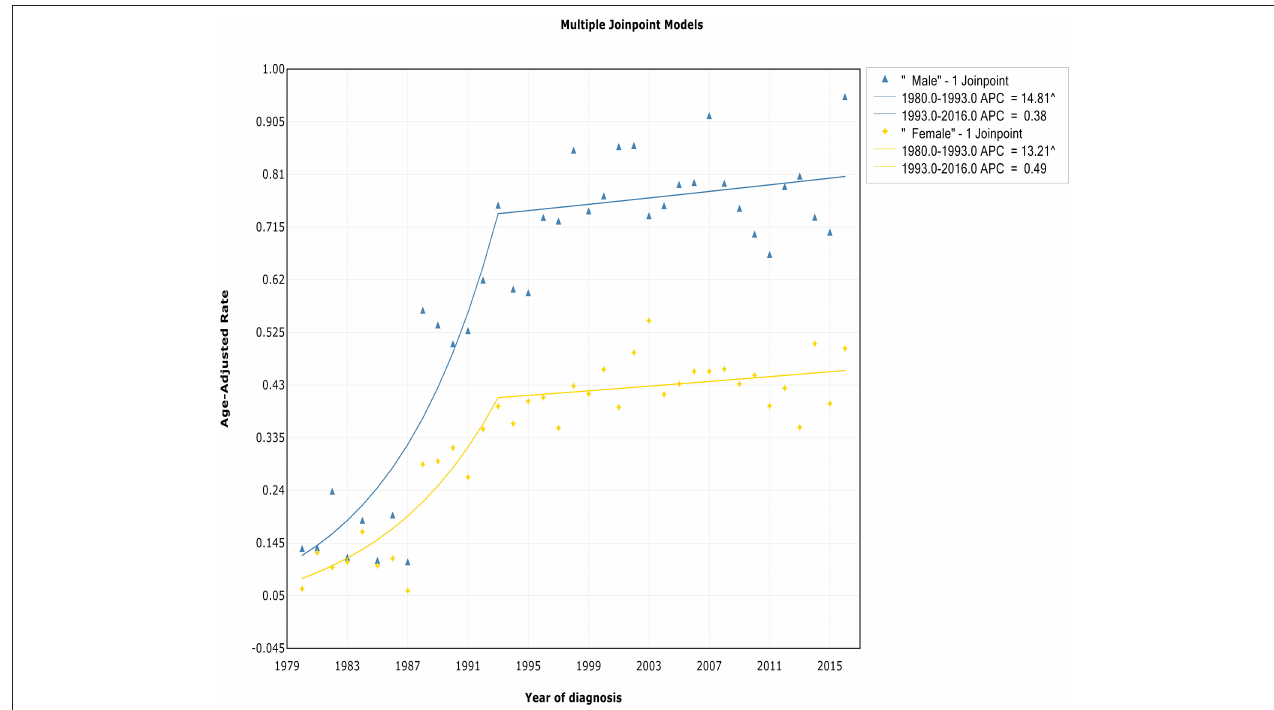
FIGURE 3 | Trends in the annual incidence of Waldenström macroglobulinemia in patients stratified according to sex.